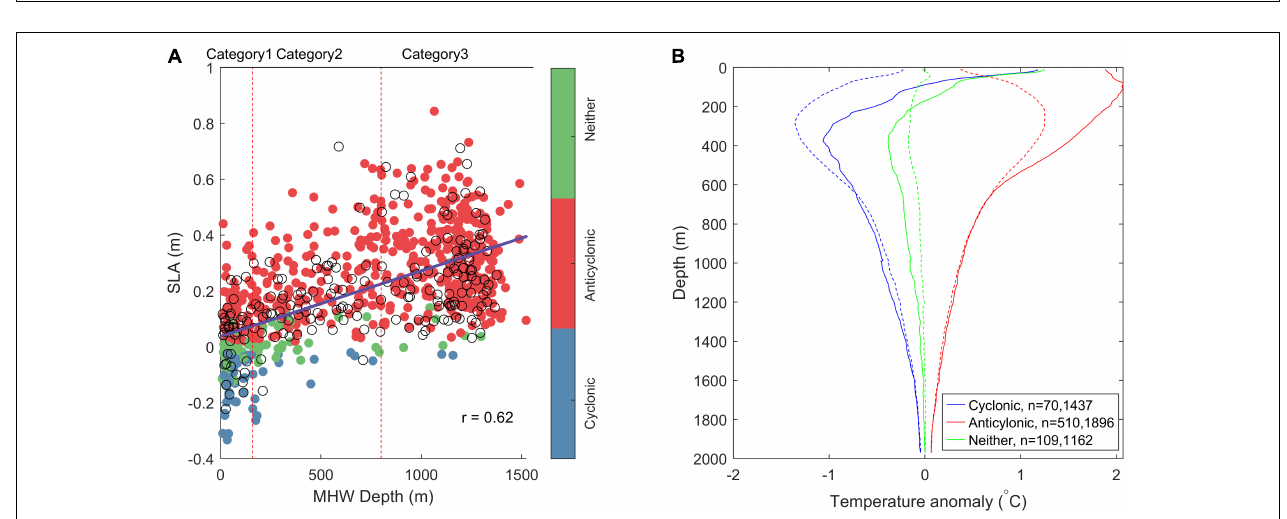
FIGURE 11 | Examples of Argo floats in an anticyclonic (A,D) , no eddy (B,E), and cyclonic (C,F) eddy for specific dates. Top panels show the corresponding sea level anomaly (SLA) and geostrophic currents with the location of the Argo float (black cross). Bottom panels show the Argo float temperature anomaly profile and the corresponding calculated MHW depth. The marked circle around the Argo float outlines the 250 km radius used to search for nearby eddies.